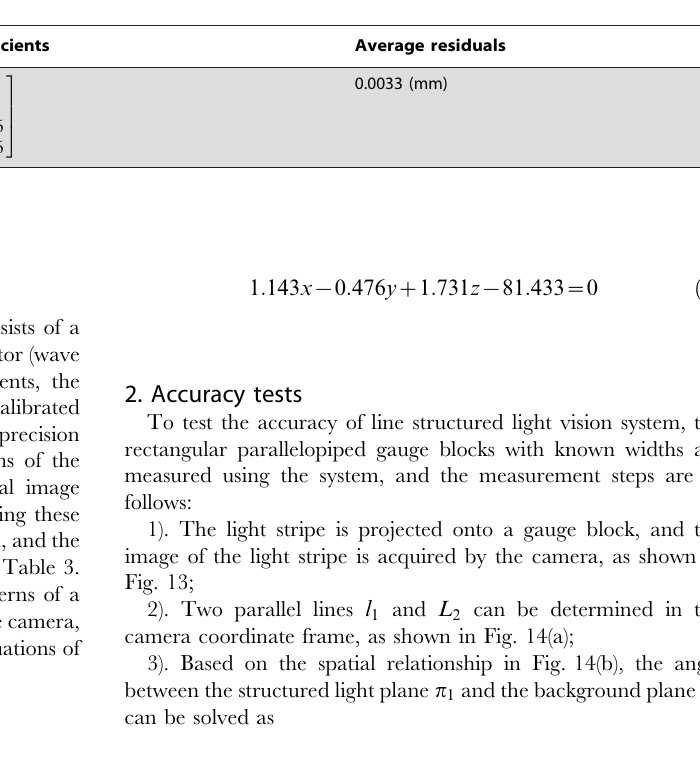
Table 3. Parameters of Zhang’s method.